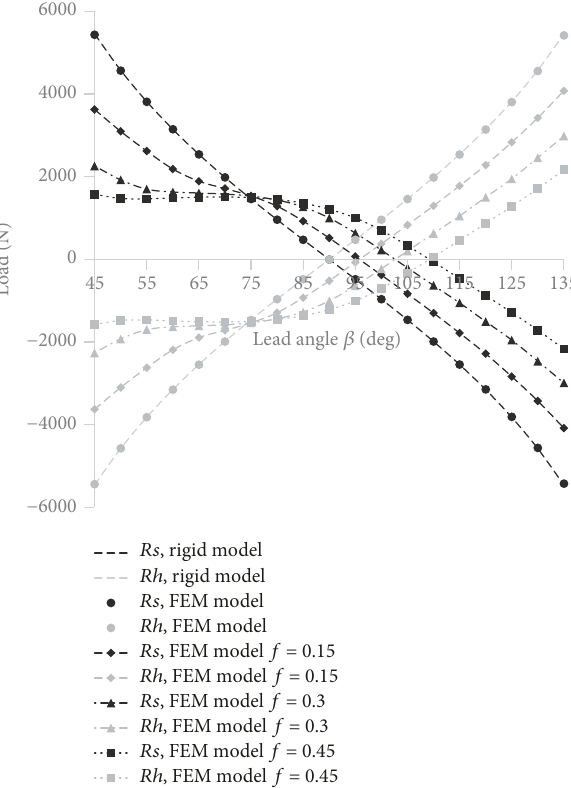
Figure 7: Reactions of shaft and hub constraints for different lead anglesunderaxialforceloadcalculatedbymeansoffrictionlessrigid and FEM model without and with friction.